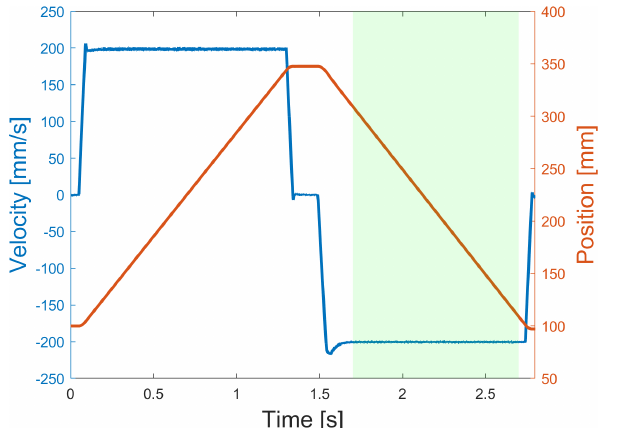
Figure 4. Working cycle depicted as position (red) and velocity (blue) consisting of forward stroke, waiting time, and return stroke, as well as the period (green) evaluated for estimation of the